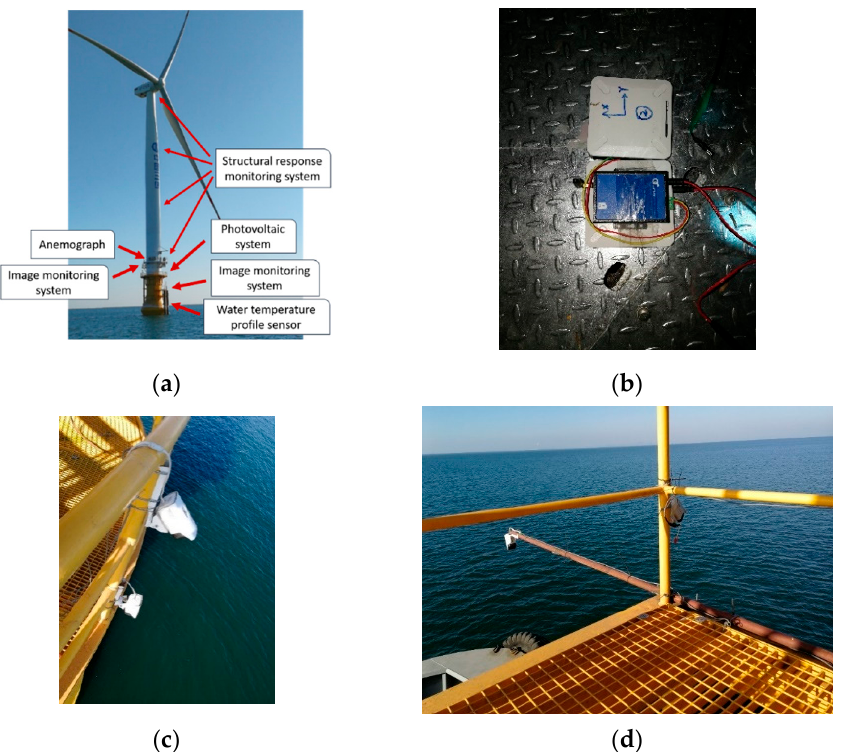
Figure 1. FMS implementation on an OWT foundation: ( a ) FMS implementation on an OWT foun- dation; ( b ) acceleration tilt sensors; ( c ) first set of ice-image cameras; ( d ) second set of ice-image cameras.